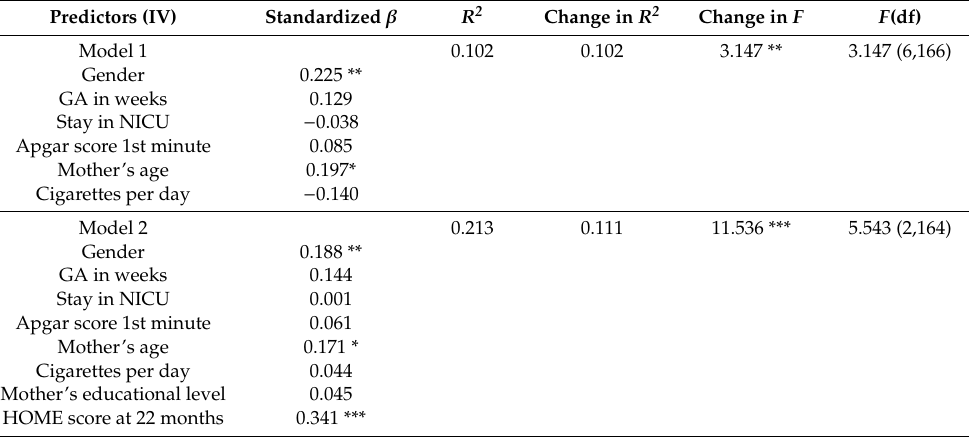
Table 3. Linear Regression analysis: predictors of BDI cognitive scores at 22 months.